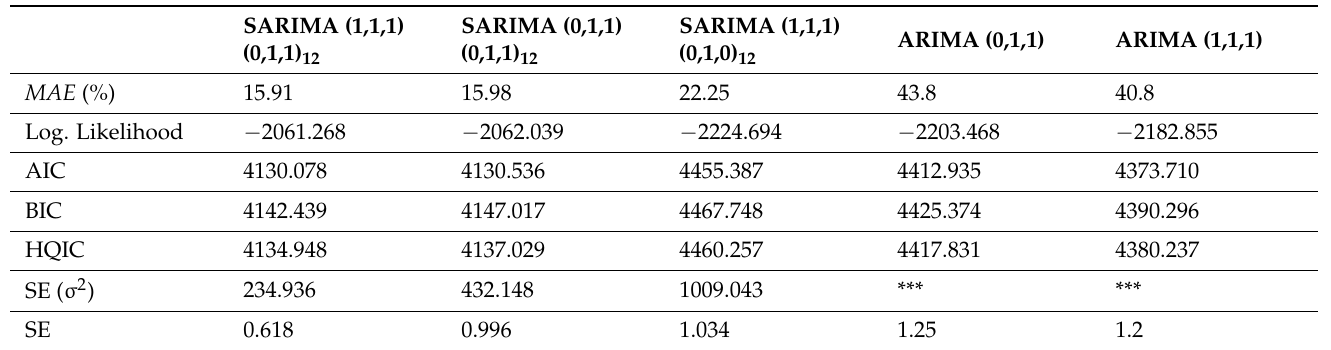
Table 3. Statistical assessment between different ARIMA and SARIMA